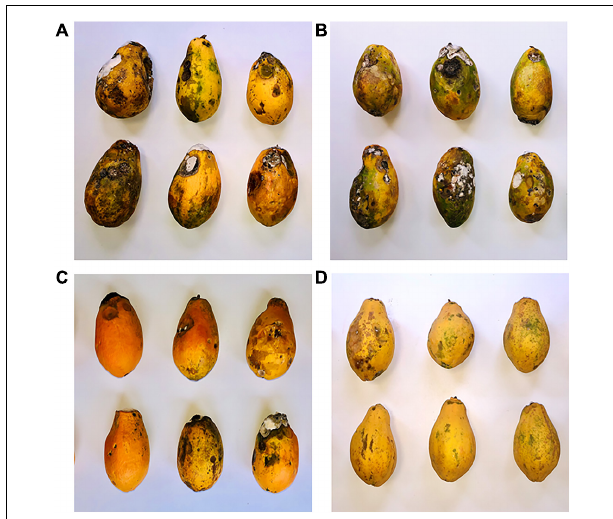
FIGURE 1 | Representative images of incidence of postharvest decay in papaya fruit following 9 days of storage at 25 ◦ C ± 1 ◦ C after the treatments with water ( A ; control), 0.5% chitosan (CS) (B) , 0.5% Ruta graveolens essential oil (REO) (C) , and their combination 0.5% chitosan, 0.5% Ruta graveolens essential oil (CS-REO) (D)